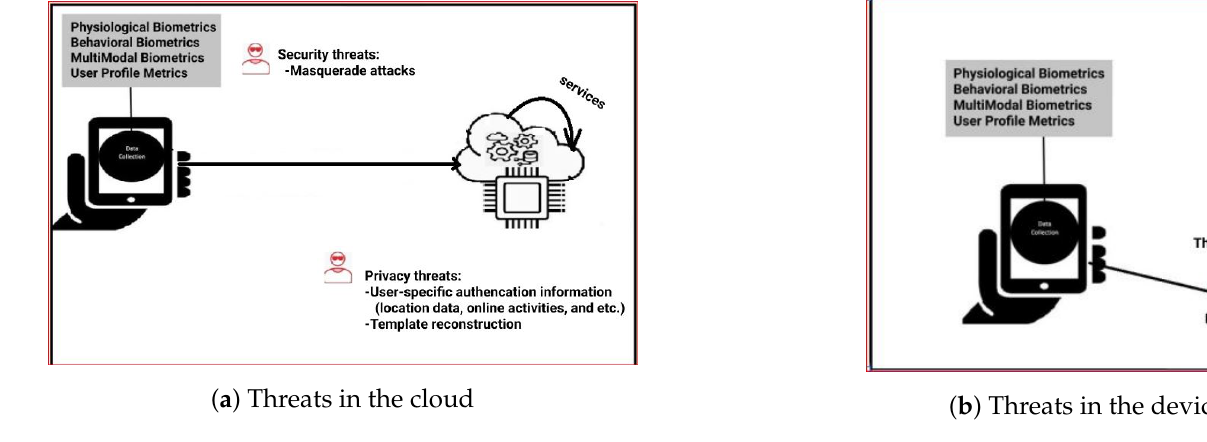
Figure 1. The threat model.